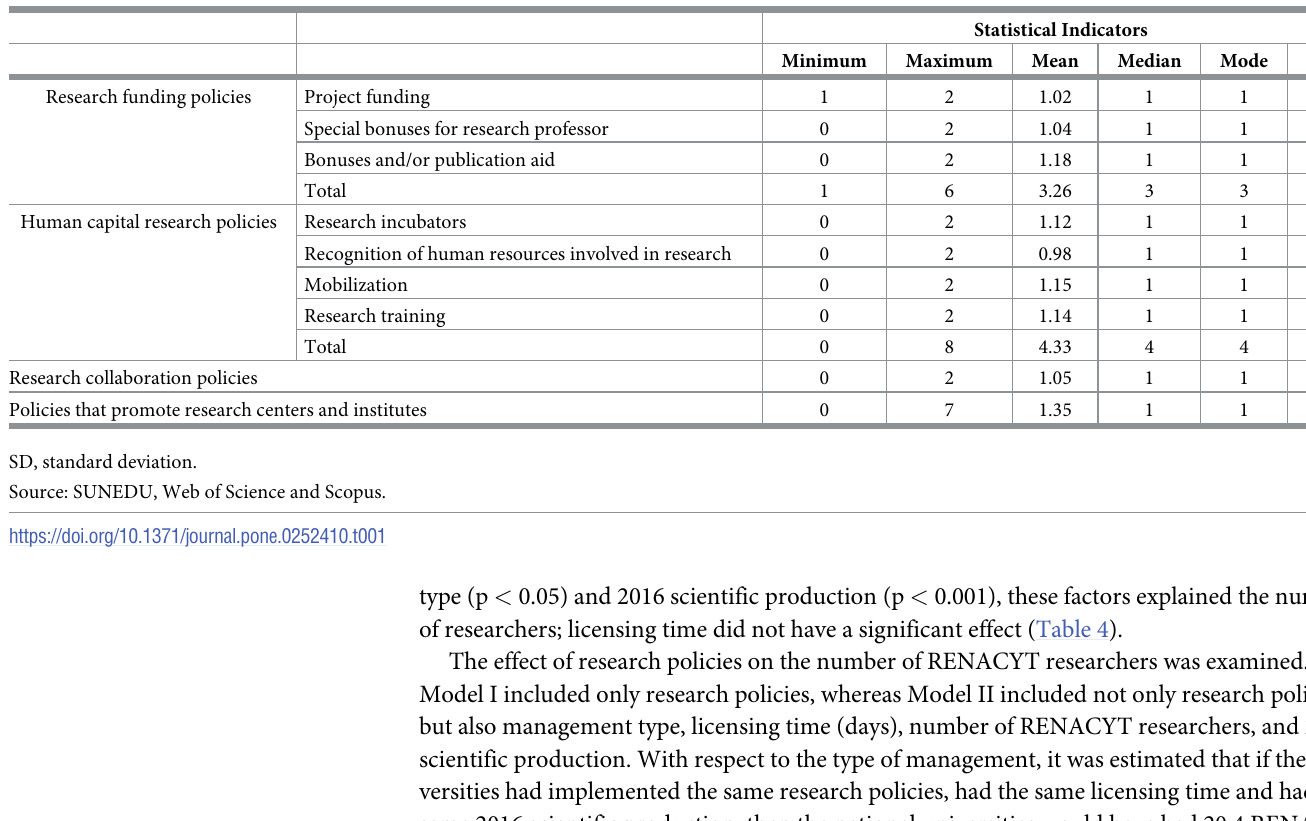
Table 1. Research policies of Peruvian universities and licensed graduate schools.